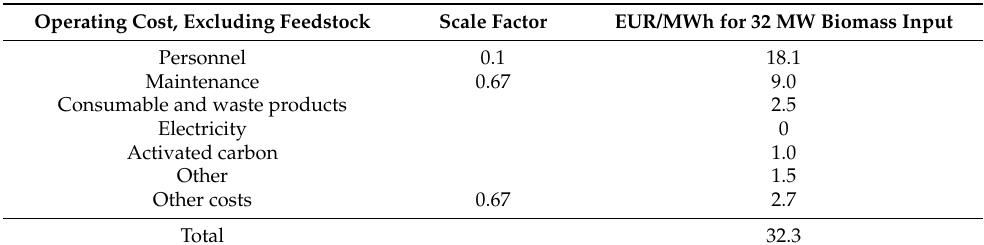
Table 5. Operating expenses (in EUR/MWh biomass input) for the DFB loop and the gas-handling section. Adapted from